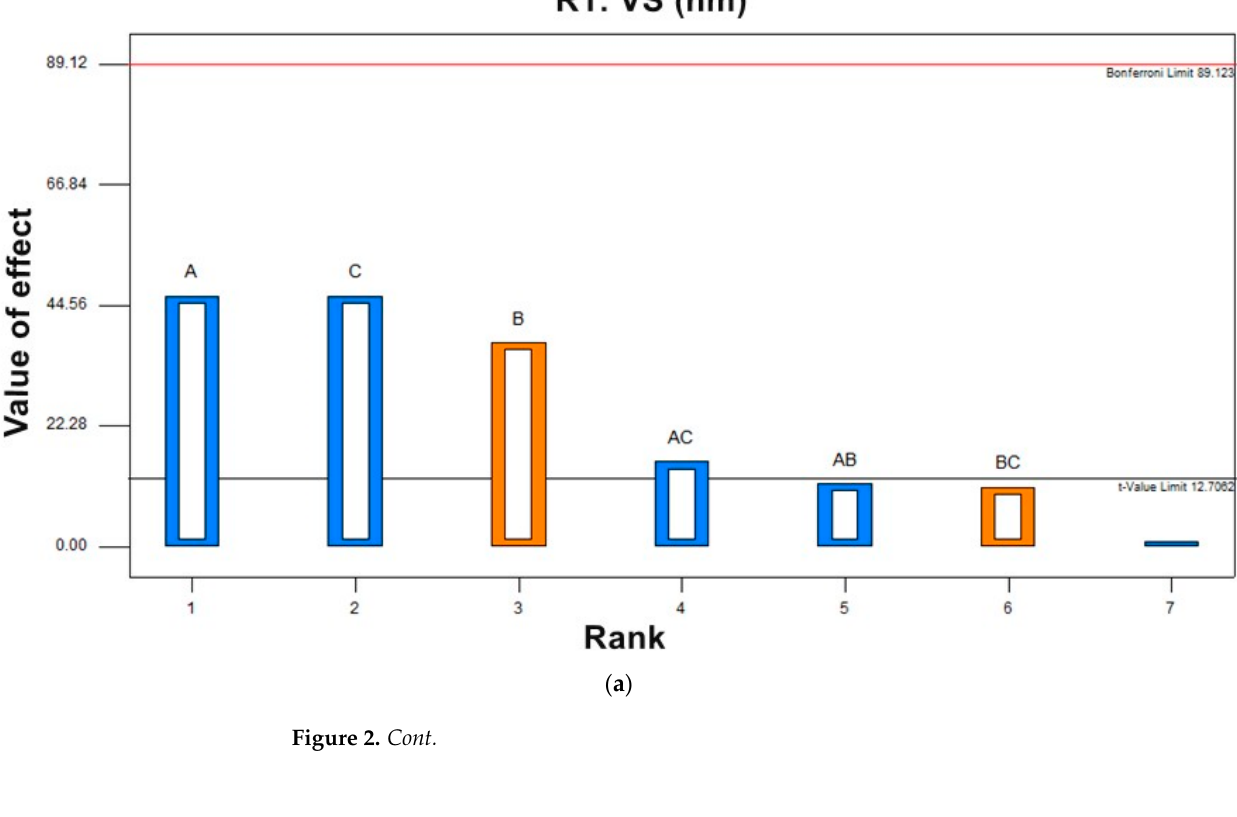
Table 3. 2 3 full factorial design results.